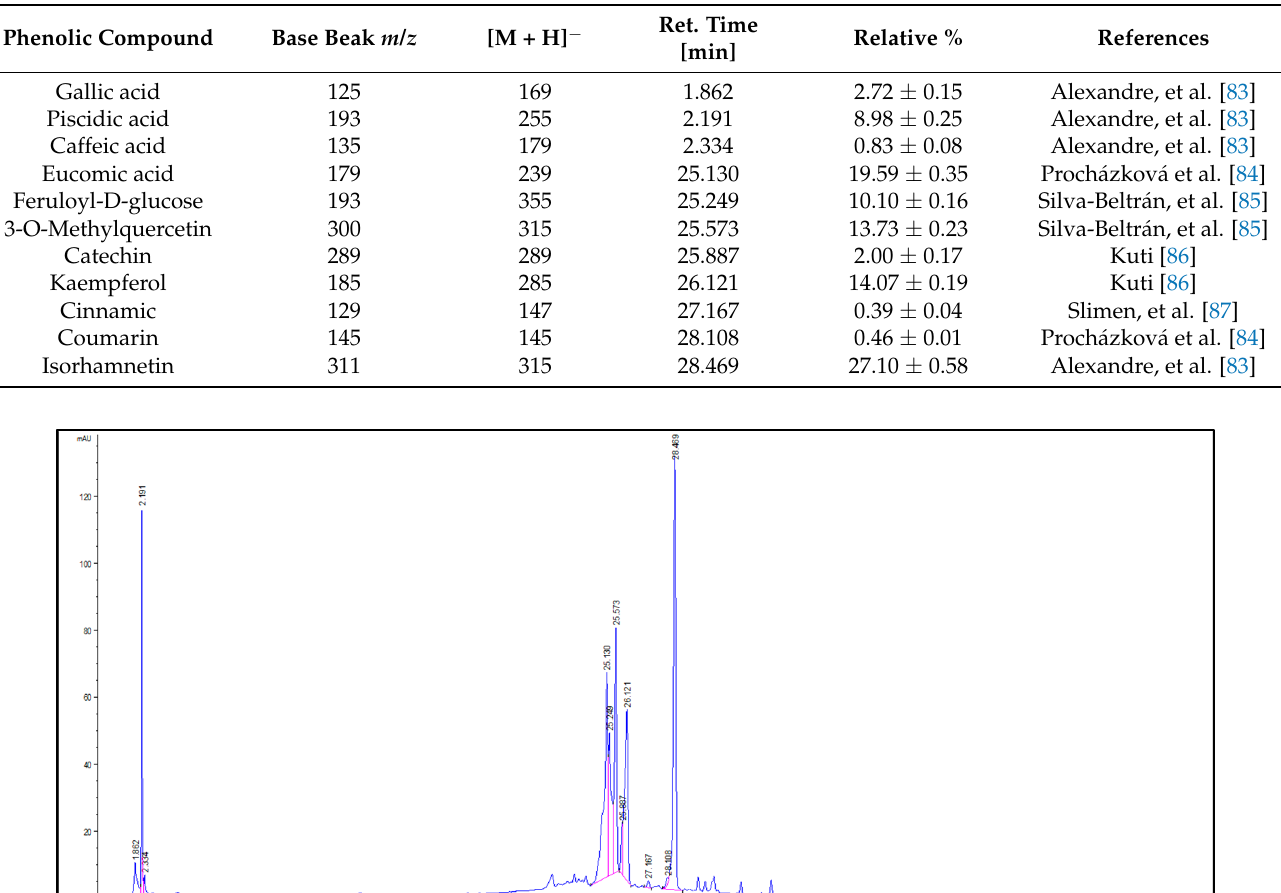
Table 5. LC-Tandem MS of polyphenolic compounds of prickly pear peel, in negative mode (EI)-MS.